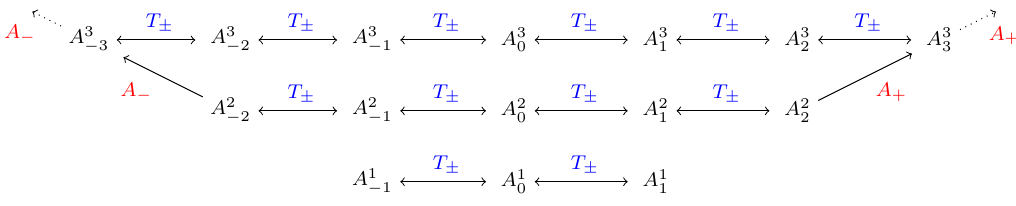
and then first acting repeatedly with ∓ 2 = T 1 to obtain A ‘ ± m ± 1